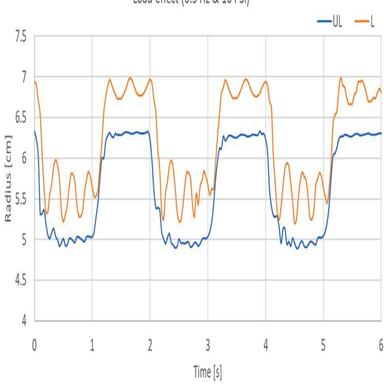
Radius – load effect (0.5 Hz & 10 psi).